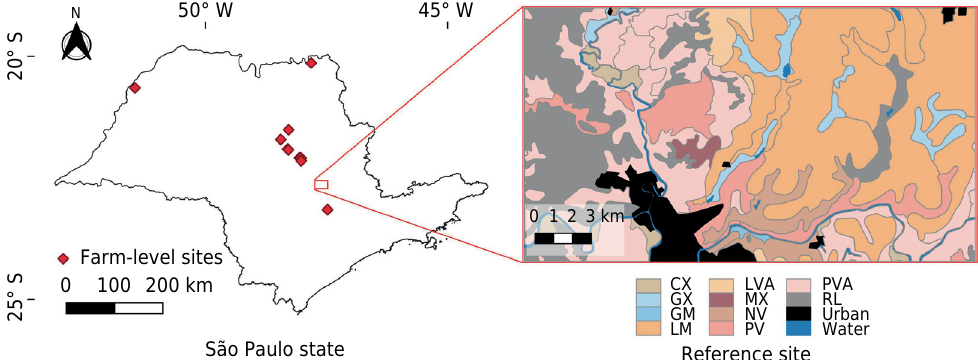
Figure 1. Study area representing the São Paulo State and several farm-level sites (left). The reference site near the Piracicaba municipality with a semi-detailed pedological map (right, scale 1:100,000) is also highlighted. CX: Cambisol ( Cambissolo ), GX: Gleysol ( Gleissolo ), GM: Histic Gleysol ( Gleissolo Hístico ), LV: Ferralsol (Redddish) ( Latossolo Vermelho ), LVA: Ferralsol (Yellowish-red) ( Latossolo Vermelho Amarelo ), MX: Haplic Phaeozem ( Chernossolo Háplico ), NV: Eutric Nitisol ( Nitossolo Eutrófico ), PV: Acrisol ( Argissolo Vermelho ), PVA: Lixisol (Argissolo Vermelho Amarelo ), RL: Regosol ( Neossolo Regolítico